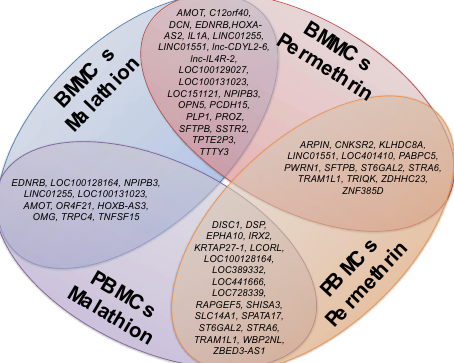
Figure 9. Genes with altered expression in more than one treatment condition and tissue. Results derived from the analysis of the top and bottom 100 genes over or underexpressed in BMMCs and PBMCs, exposed to malathion or permethrin. Figure shows genes that where concordant between two different